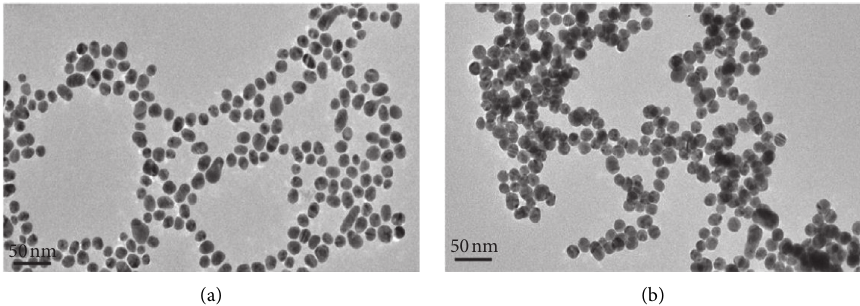
Figure 4: HRTEM micrographs of (a) Cit-HAuNPs and (b) Cit-MAuNPs at 50000x magnification.